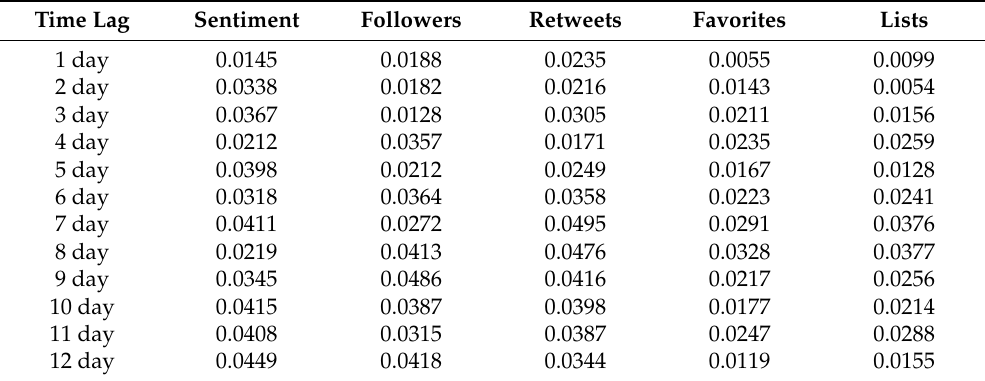
Table 10. Statistical significance ( p -values) of bivariate Granger causality correlation for Stellar popularity based on tweet sentiment, followers, retweets, favorites, and lists. Time Lag Sentiment Followers Retweets